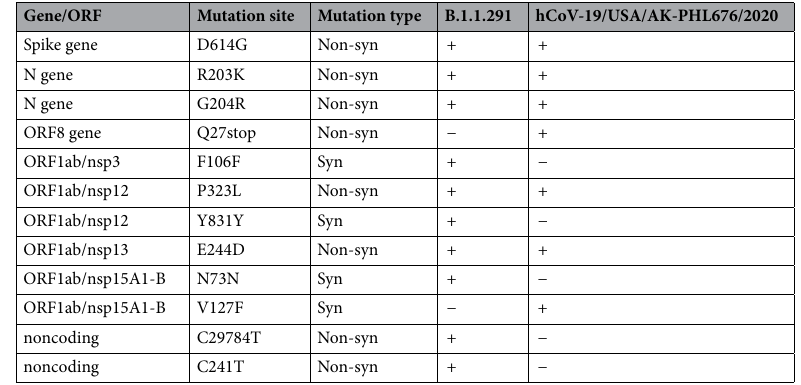
Table 1. Comparison of hCoV-19/USA/AK-PHL676/2020 with genome signature of B.1.1.291.